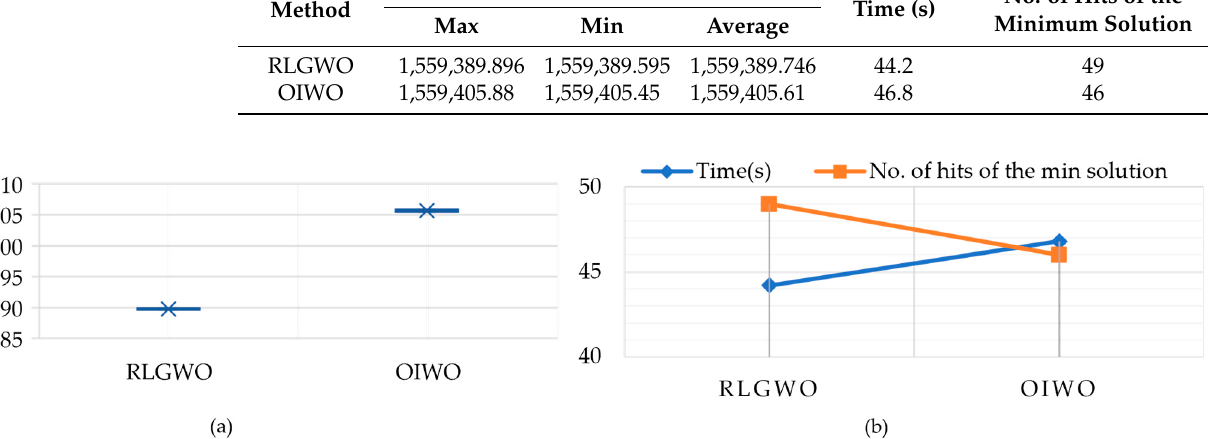
Table 9. Best simulation results for the 160 ‐ unit system with loss ( 𝑃 (cid:3005) (cid:3404) 43200𝑀𝑊 ).